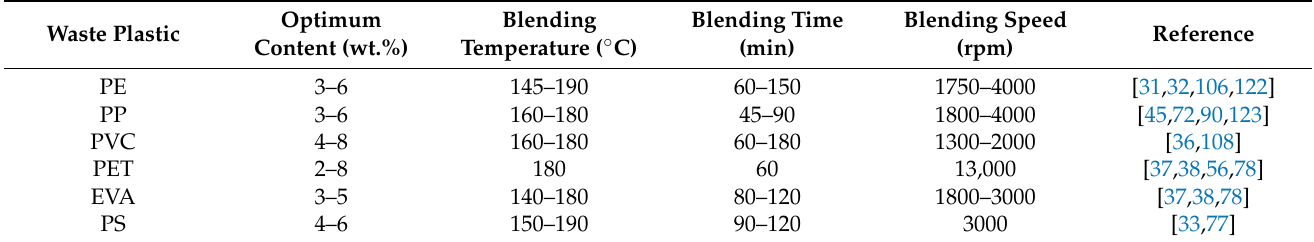
Table 5. Blending conditions commonly used for waste plastic-modified asphalt.